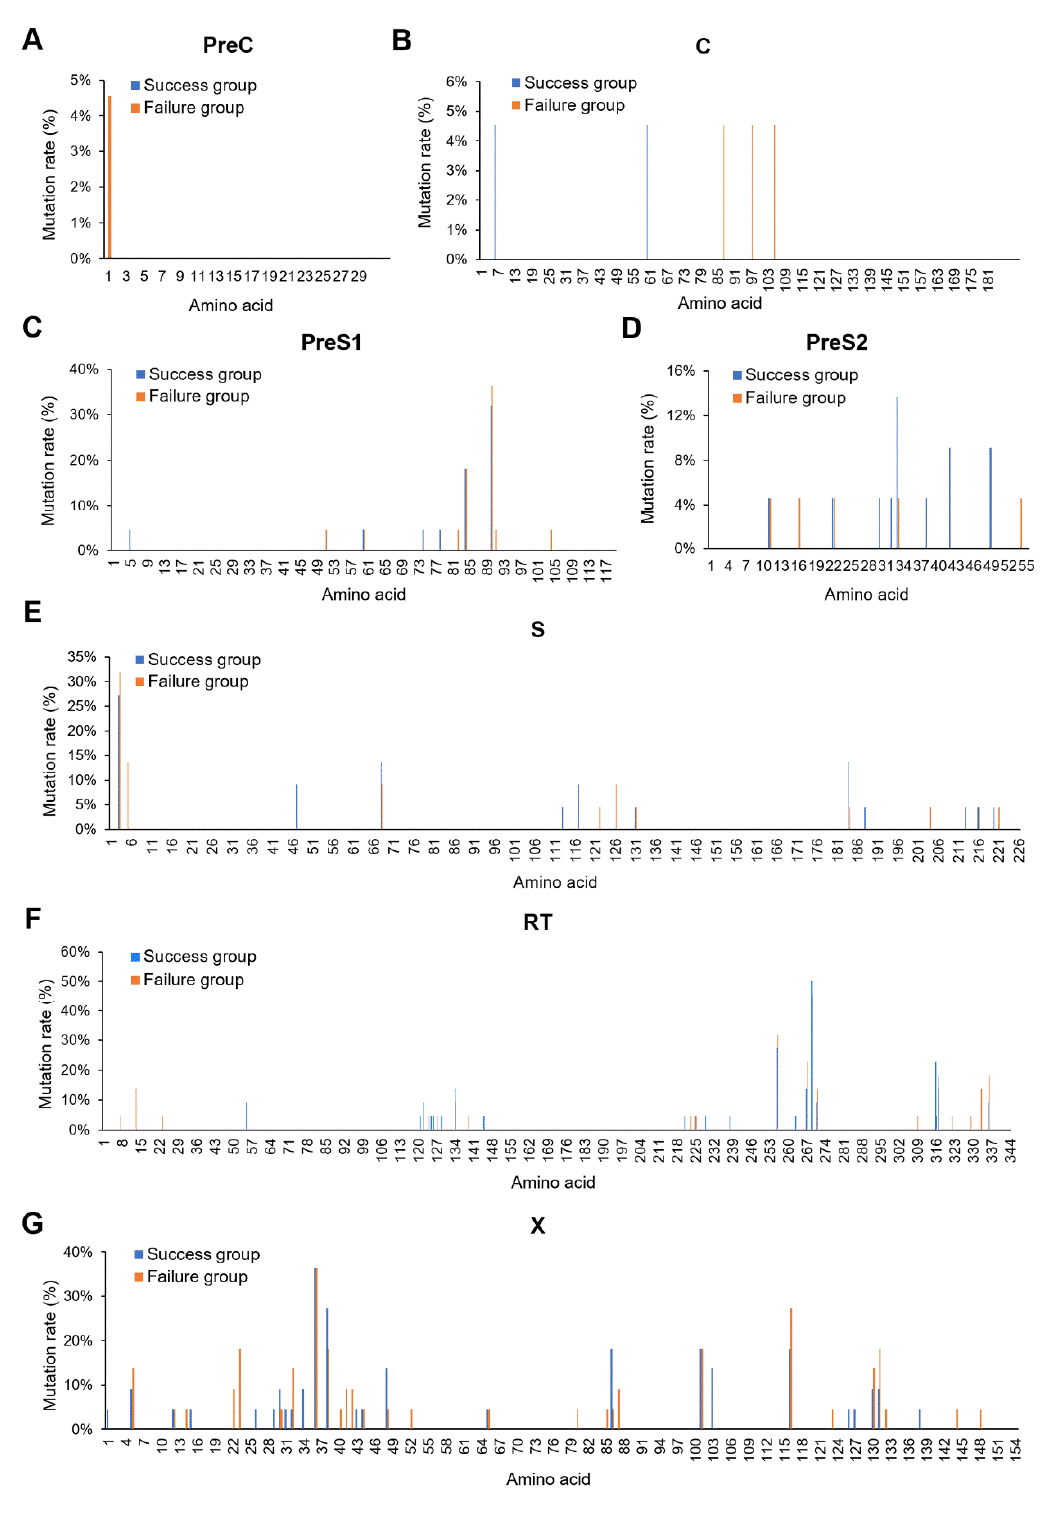
Figure 1 . Amino acid mutations in the HBV coding regions. The amino acid mutation rates of the HBV preC ( A ), C ( B ), preS1 ( C ), preS2 ( D ), S ( E ), RT ( F ), and X ( G ) regions were analyzed in the mothers of the immunoprophylaxis failure and success groups. All of the mutations were defined on the basis of the same consensus sequence synthesized by all clones from the mothers.